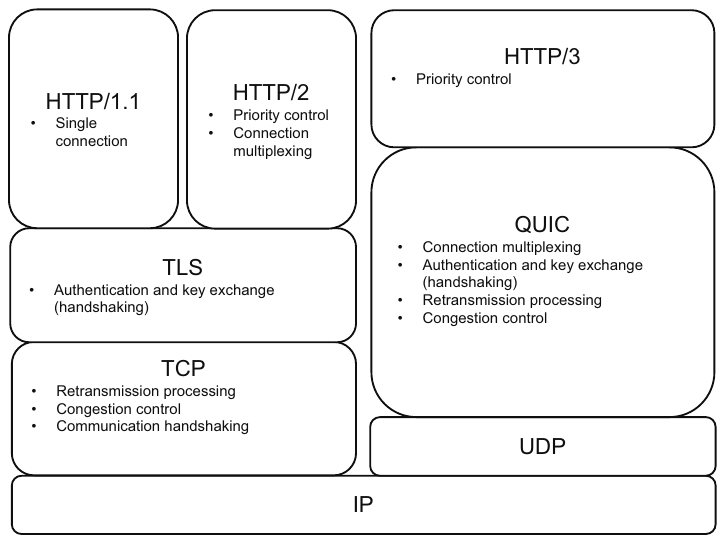
Figure 1. Overview of new and old HTTP